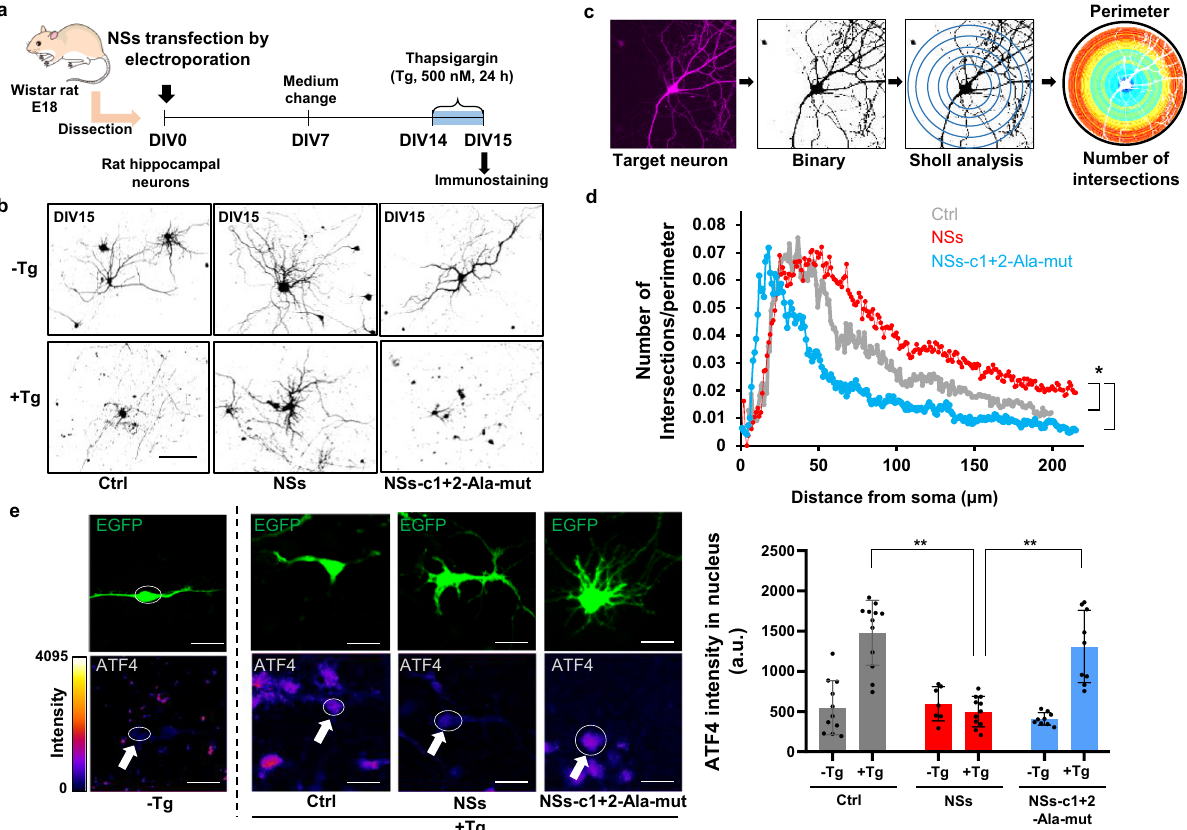
Fig. 5 SFSV NSs in rat primary hippocampal neurons attenuates the ISR induction and protects the neuronal morphology. a Schematic illustration of thapsigargin treatment (500 nM) for rat primary hippocampal neurons. The neurons were transfected with the control plasmid, the SFSV NSs-expression plasmid, or the SFSV NSs-c1 + 2-Ala-mut-expression plasmid by electroporation. b Representative images of hippocampal neurons with or without Tg treatment after 24 h. Tg treatment shortened the neurites in the control and NSs-c1 + 2-Ala-mut-expressing cells, whereas NSs counteracted Tg. Scale bar = 100 µ m. c Schematic representation of the Sholl analysis. d The Sholl analysis revealed that NSs protected the arborization of neurons. n = 5. e NSs downregulated ATF4 expression induced by Tg (500 nM, 3 h), as compared to the control and NSs-c1 + 2-Ala-mut. n = 3 (seven targeted neurons), n means the number of independent experiments. * p < 0.05, a.u., arbitrary units. Scale bar = 10 µ m. The 12-bit scale of fl uorescent intensity is shown as color coded. d One-way ANOVA with Tukey ’ s multiple comparisons test. e Two-way ANOVA with Tukey ’ s multiple comparisons test. Error bars ± SD. a , b DIV, days in vitro. Source data are provided as a Source Data fi